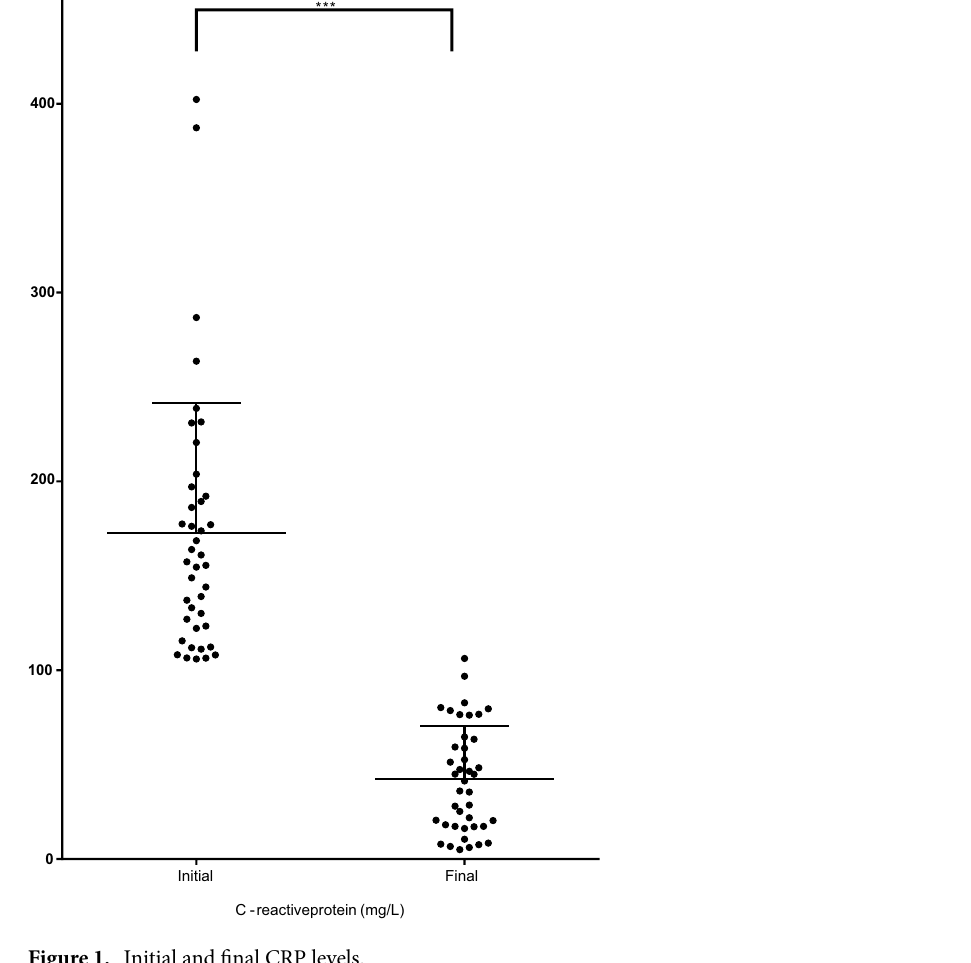
Figure 1. Initial and final CRP